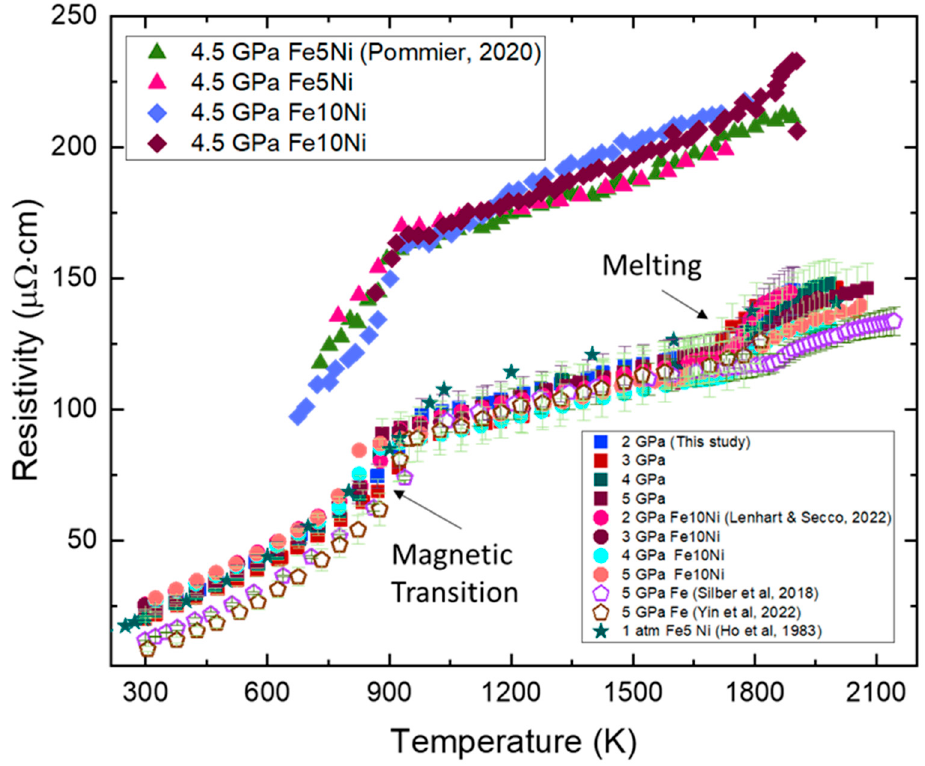
Figure 4. Comparison of the electrical resistivity of Fe-5 wt% Ni and Fe-10 wt% Ni [11,17,27–29].